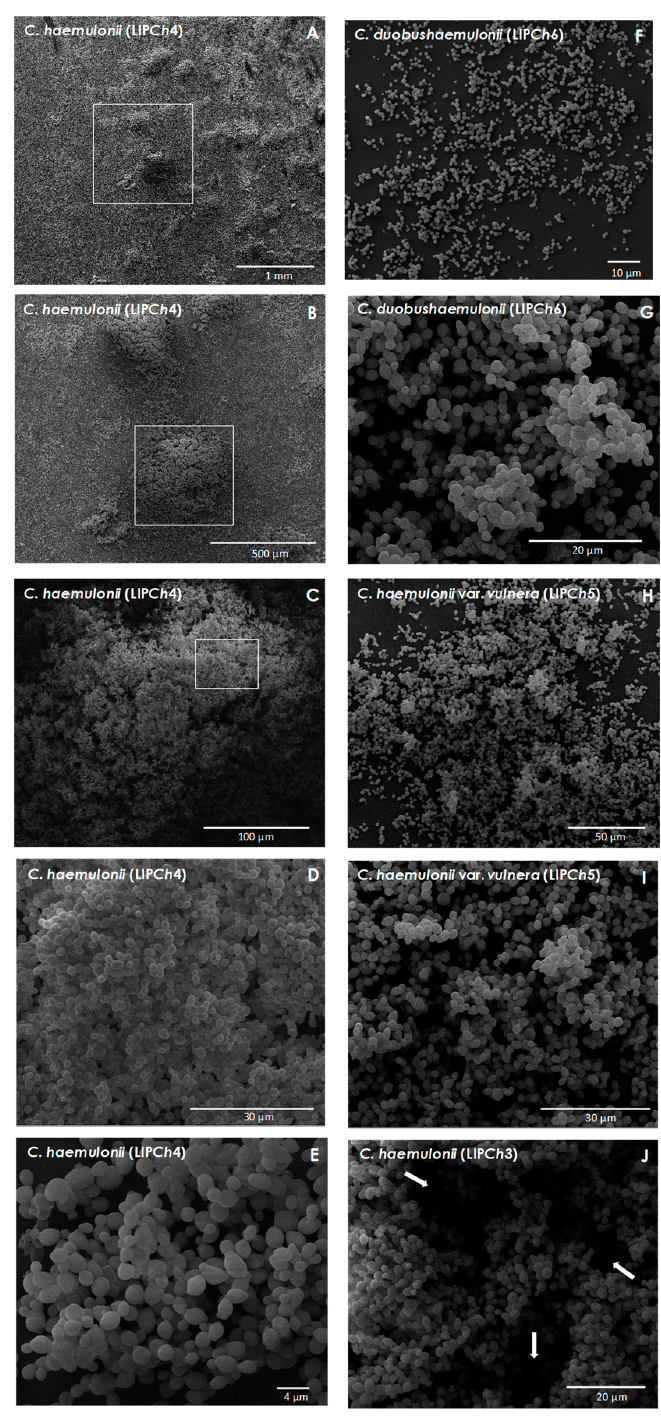
Figure 3. Representative low-magnification scanning electron microscopy (SEM) images of the biofilms formed by the C. haemulonii species complex on polystyrene surface. Yeasts (200 µ L containing 10 6 cells) were placed to interact with polystyrene coverslips for 48 h at 37 °C, after which the coverslips were visualized using SEM. The images revealed a dense network of yeast cells. In the panel, the images on the left side exhibit different magnifications of the biofilm formed by the isolate LIP Ch 4 of C. haemulonii ( A to E ) while on the right side, it is possible to see the biofilms of isolate LIP Ch 6 of C. duobushaemulonii ( F and G ) and LIP Ch 5 of C. haemulonii var. vulnera ( H and I ). Representative water channels are indicated by white arrows in the image of isolate LIP Ch 3 of C. haemulonii ( J ). Note that the white square in A is the place that was chosen to be amplified and shown in B , and this logic sequence was used in the left side images from A to D .